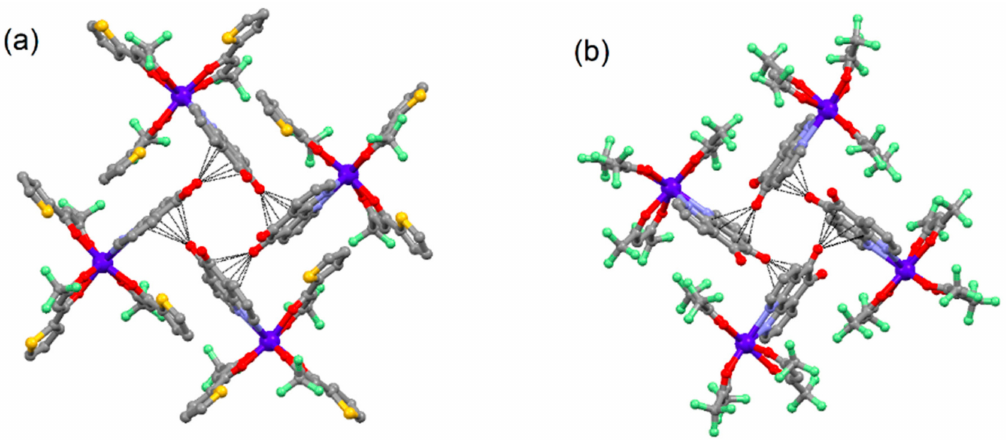
Figure 2. Crystal packing of ( a ) 1 and ( b ) 2 with highlights of the π - σ interaction. [Dy(hfac) 3 ( L )] ( 2 ). The X-ray structure of 2 is similar to that of 1 . It crystallized in the tetragonal